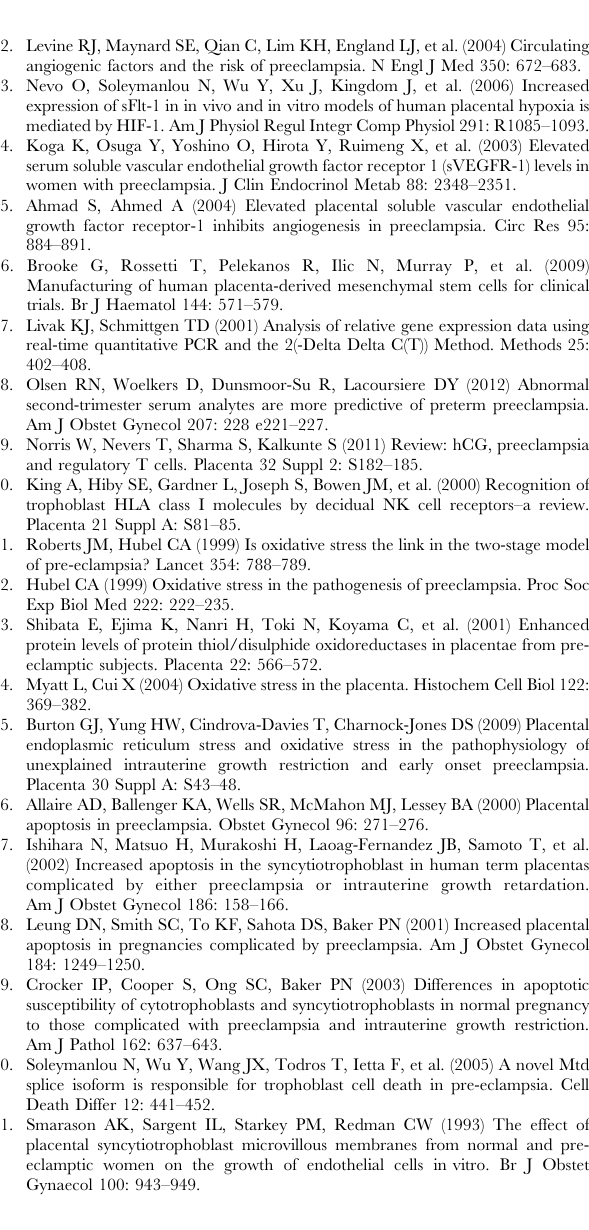
Table S1 Cytokines Expression in Normal vs Pre- eclamptic PDMSCs Conditioned